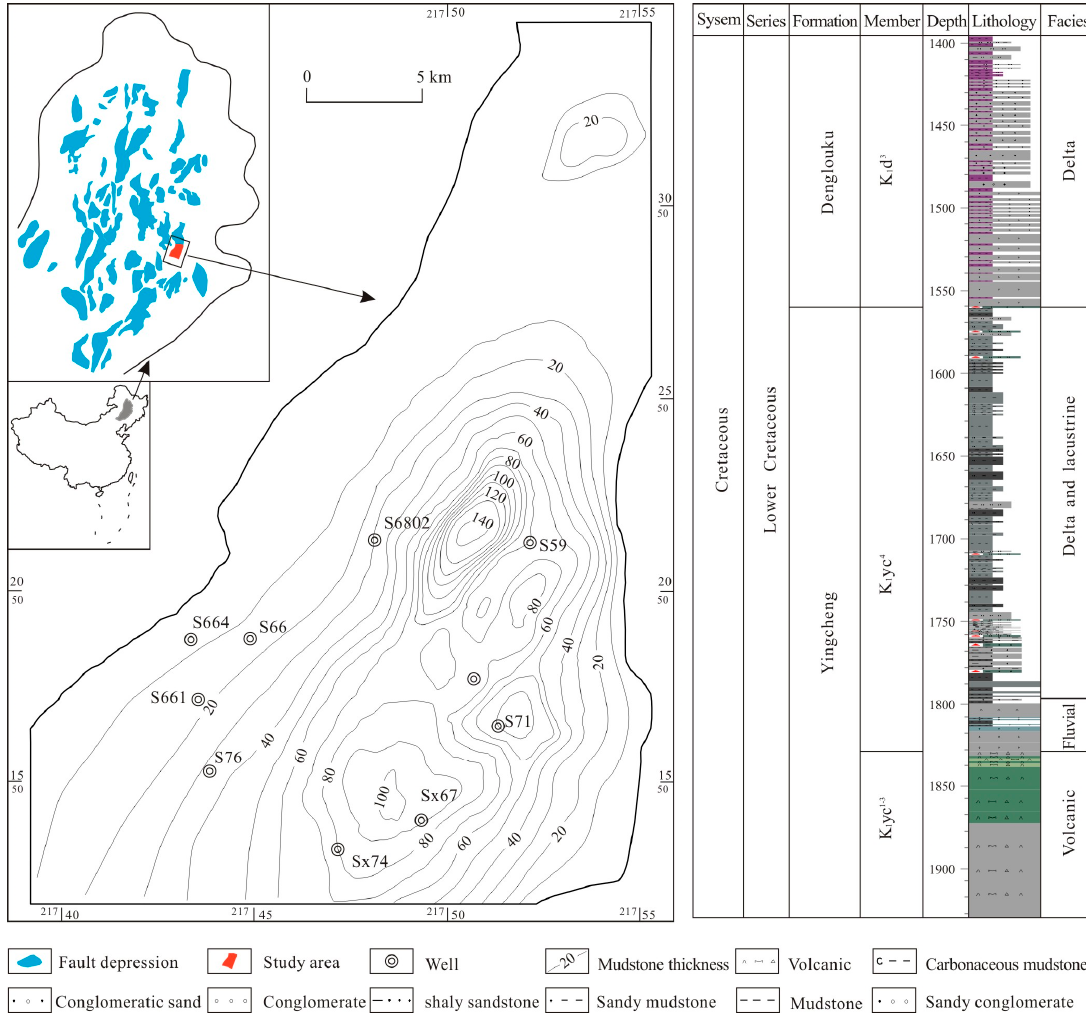
Figure 1. The mudstone thickness and lithological characteristics of K 1 yc 4 in the South Shuangcheng Fault Depression. Shuangcheng Fault Depression is located in the eastern margin of the Southeastern Uplift Area of the Songliao Basin, in the southeast of Xujiaweizi Fault Depression, adja- cent to Yingshan Fault Depression (Figure 1). The sedimentary strata in the fault depres- sion are distributed in an area of about 5500 km 2 . Shuangcheng Fault Depression is composed of Lower Cretaceous strata, including the Huoshiling Formation (K 1 h), the Yingcheng Formation (K 1 yc), the Denglouku Formation (K 1 d) and the Quantou For- mation (K 1 q); Upper Cretaceous strata, containing the Qingshankou Formation (K 2 qn), the Yaojia Formation (K 2 y) and the Nenjiang Formation (K 2 n); Tertiary, including the Taikang Formation (N 2 t); and the Quaternary System [14,15]. The sedimentary strata in this area are missing the Shahezi Formation (K 1 sh) of the Lower Cretaceous, the Mingshui Formation (K 2 m) and Sifangtai Formation (K 2 s) of the Upper Cretaceous, and the Da’an Formation and Yi’an Formation of the Tertiary [16]. Exploration in the Shuangcheng Fault Depression has gone through the exploration stages of a shallow secondary gas reservoir, a volcanic gas reservoir and the Yingcheng–Denglouku reser- voir. A set of high-quality source rocks has developed in K 1 yc 4 , which is a deep sedi- mentary stratum in the South Shuangcheng Fault Depression (Figure 1). The source rocks are buried relatively shallow, and their thermal evolution reached the mature stage of oil generation. The S66 well was drilled in the Denglouku Formation, and the oil-bearing